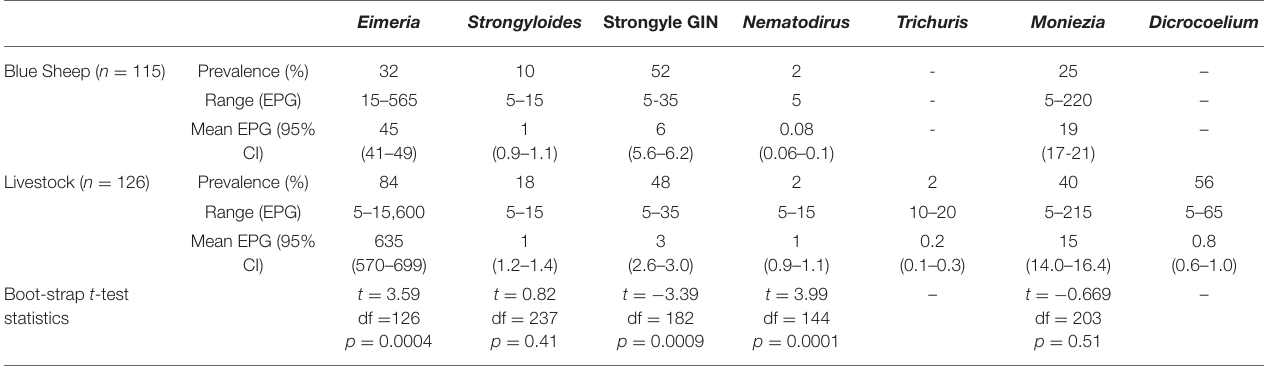
TABLE 4 | Endoparasites in livestock and bharal (blue